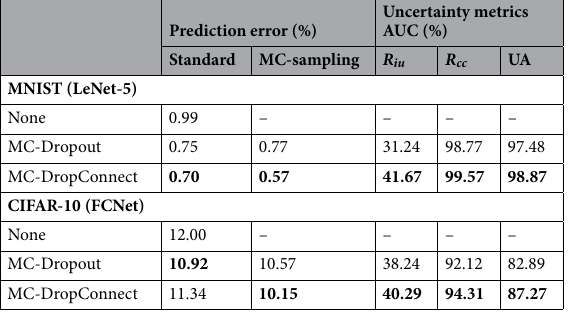
racy of the FCNet on CIFAR-10 dataset and over a different number of Monte Carlo simulations (T). We then reported the average results over 10 runs in Fig. 6. As can be seen, MC-DropConnect results in a significantly lower prediction error than the baseline network (the black dotted line) after only 2 samples while this number is 6 for MC-Dropout. Moreover, MC-Dropconnect achieves an error less than one standard deviation away from its best performance (at T = 90) after only 18 samples, while this number is 54 for MC-Dropout (with its best performance at T = 94).